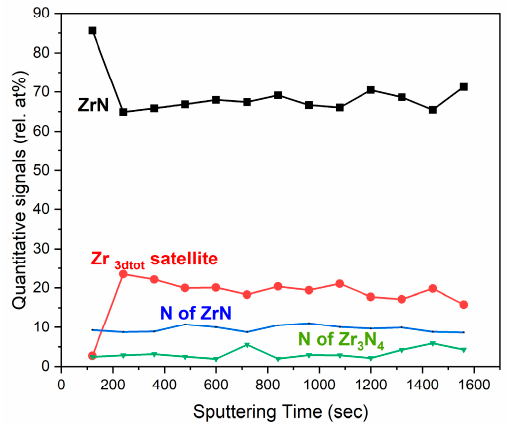
Figure 5. Sputter depth profiling of sample ZrN B for the four subcomponents extracted after peak fit and indicated on each graph.